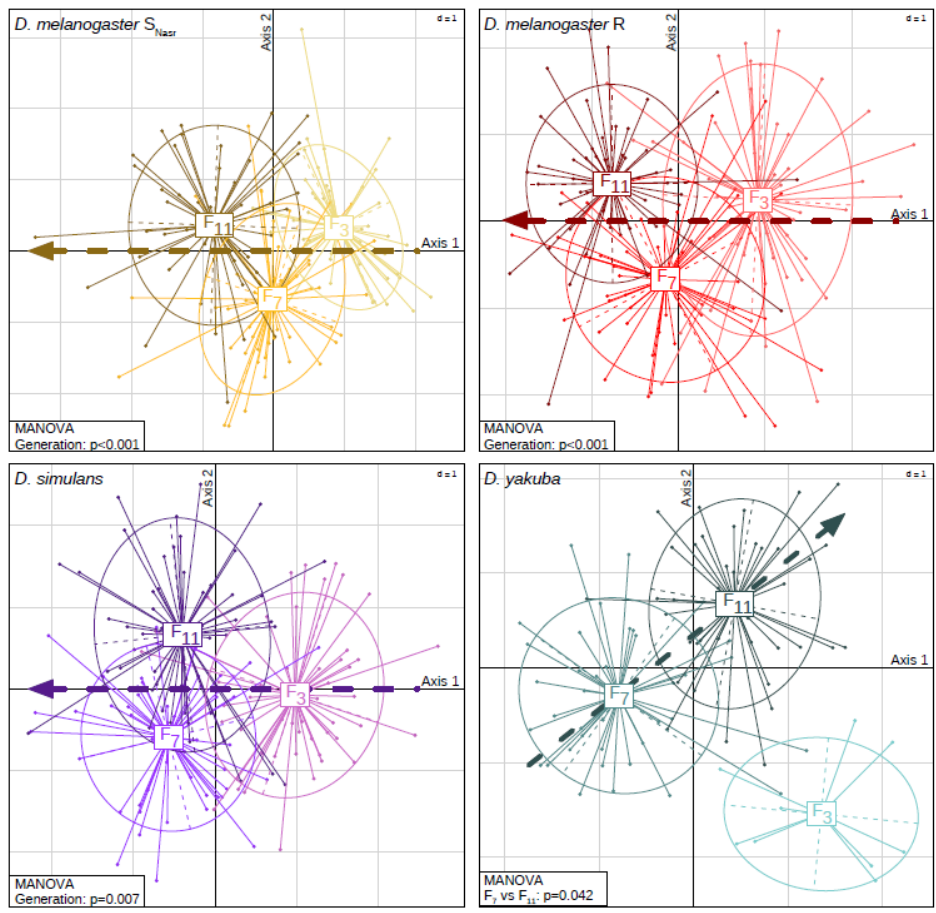
Figure 3. Evolution of the venom composition according to the selection host. Position of the individuals (shown as dots) on the two discriminant axes for each selection host. Individuals are grouped and coloured according to the generation (F 3 , F 7 and F 11 ). The arrows represent the trend of the venom evolution. The dotted arrows represent the linear regressions calculated from coordinates of the three centroid points corresponding to the F 3 , F 7 and F 11 generations and weighted by the number of individuals per generation. For D. yakuba 307, the linear regression was calculated from centroid points of F 7 and F 11 only due to the low number of females available in F 3 . P-values obtained from the PERMANOVA for the “generation” effect are provided at the bottom right of the LDA (see Table